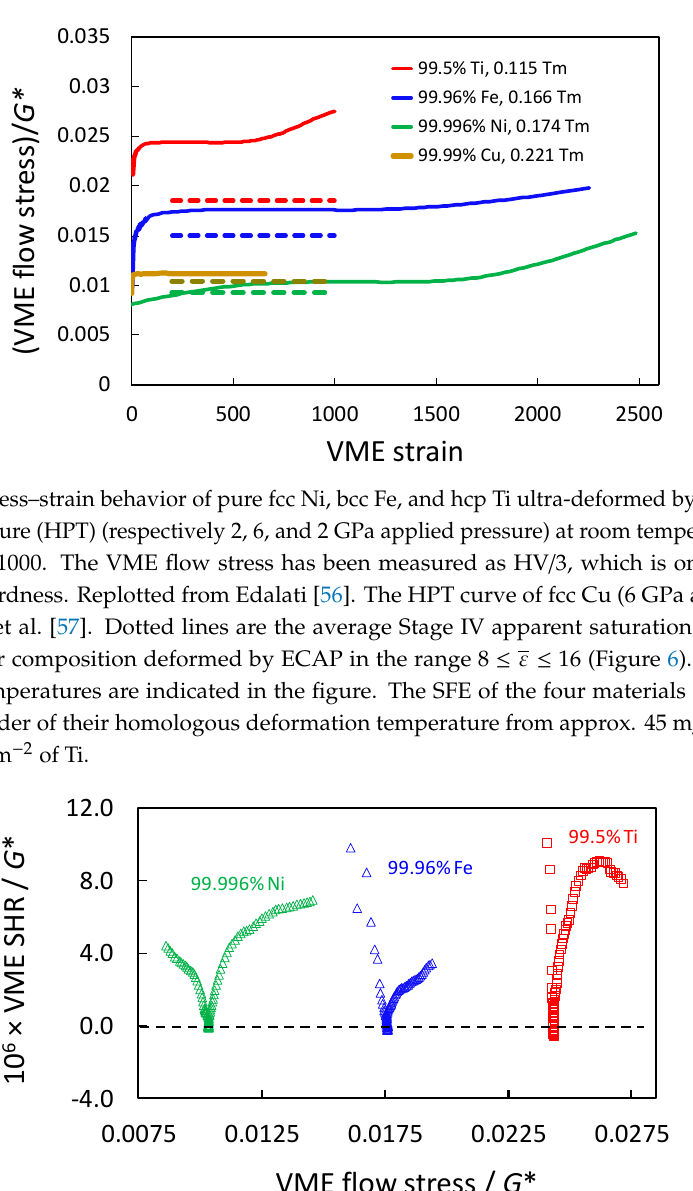
Figure 8. Normalized VME strain hardening rate, SHR / G * vs. normalized VME flow stress, σ / G ∗ for pure Ni, Fe, and Ti ultra-SPD deformed by HPT at room temperature. Derived from the stress–strain curves measured by Edalati [56], as shown in Figure 7. Saturation of Stage IV and emergence of a new hardening stage.